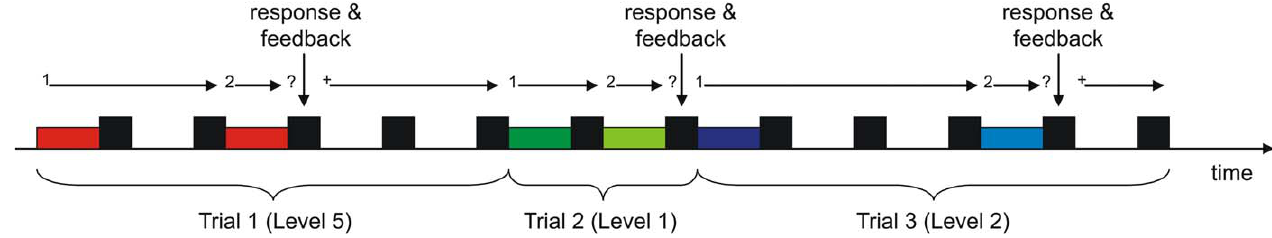
Figure 3. Schematic of the Experimental Design in Study 2 Depicted are three consecutive trials with pairs of pitch sequences drawn from entropy levels 5, 1, and 2. Coloured boxes indicate the presentation of a pitch sequence, black boxes indicate the acquisition of a scan volume, and the white gaps between scans denote silent periods. Identical colours within one trial indicate that the two pitch sequences of a pair are identical (trial 1), whereas slightly different hues indicate trials where the second pitch sequence was different from the first one, but drawn from the same entropy level (trials 2 and 3). There were three possible delays within and between trials: for example, trial 1 has a within-trial delay of two scans before the presentation of the second pitch sequences, and a between-trial delay of three scans before the beginning of the subsequent trial. Trial 2 has within-trial and between-trial delays of one scan, etc. Visual cues as depicted above the schematic of the design were presented to guide participants through the experiment. Participants received immediate feedback (correct/incorrect) after giving their